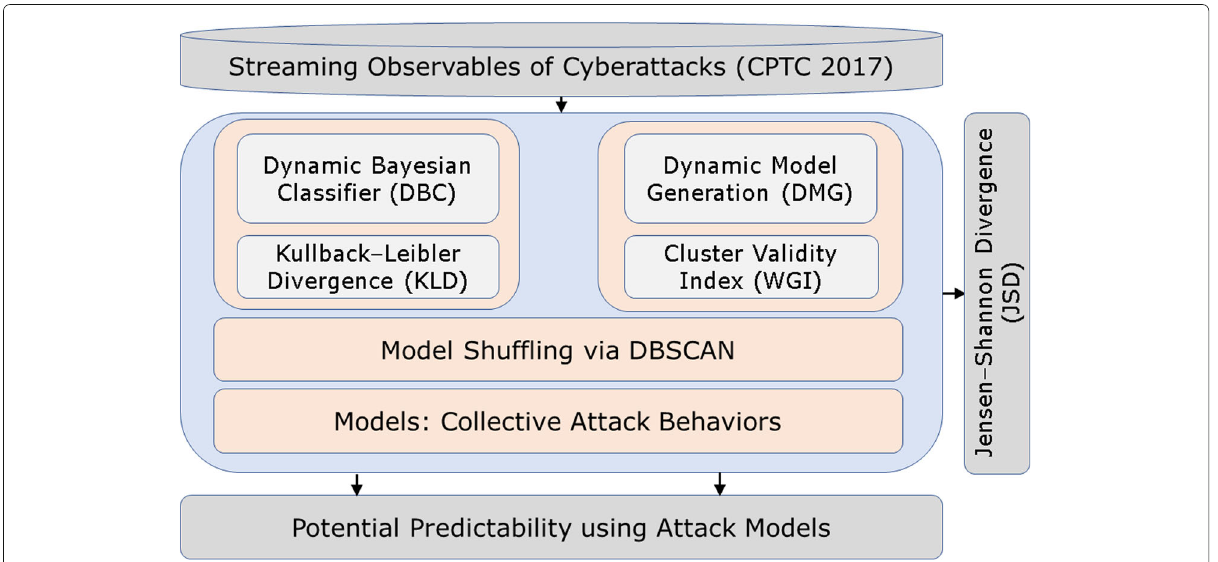
Fig. 1 The ASSERT architecture and its connection to external modules